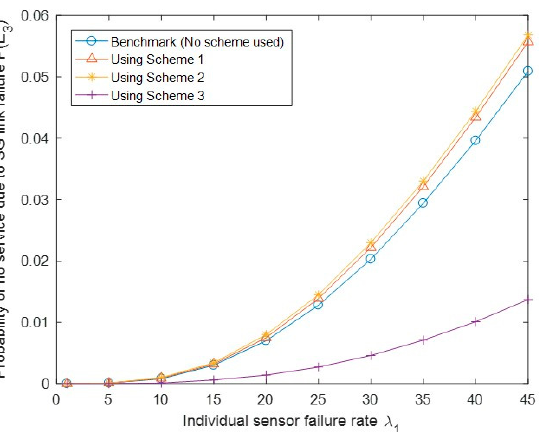
Figure 13. Performance comparison of the probability of no service due to SG link failure P ( E 3 ) under the benchmark and three API schemes.